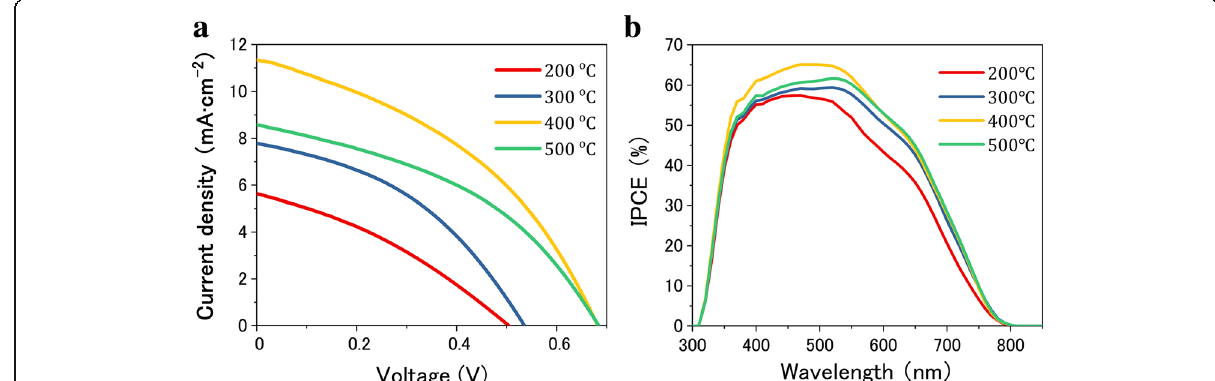
Fig. 6 a J-V curves and b IPCE spectra of the cell devices based on TiO 2 /CIS photoelectrodes with annealing treatment at different temperatures